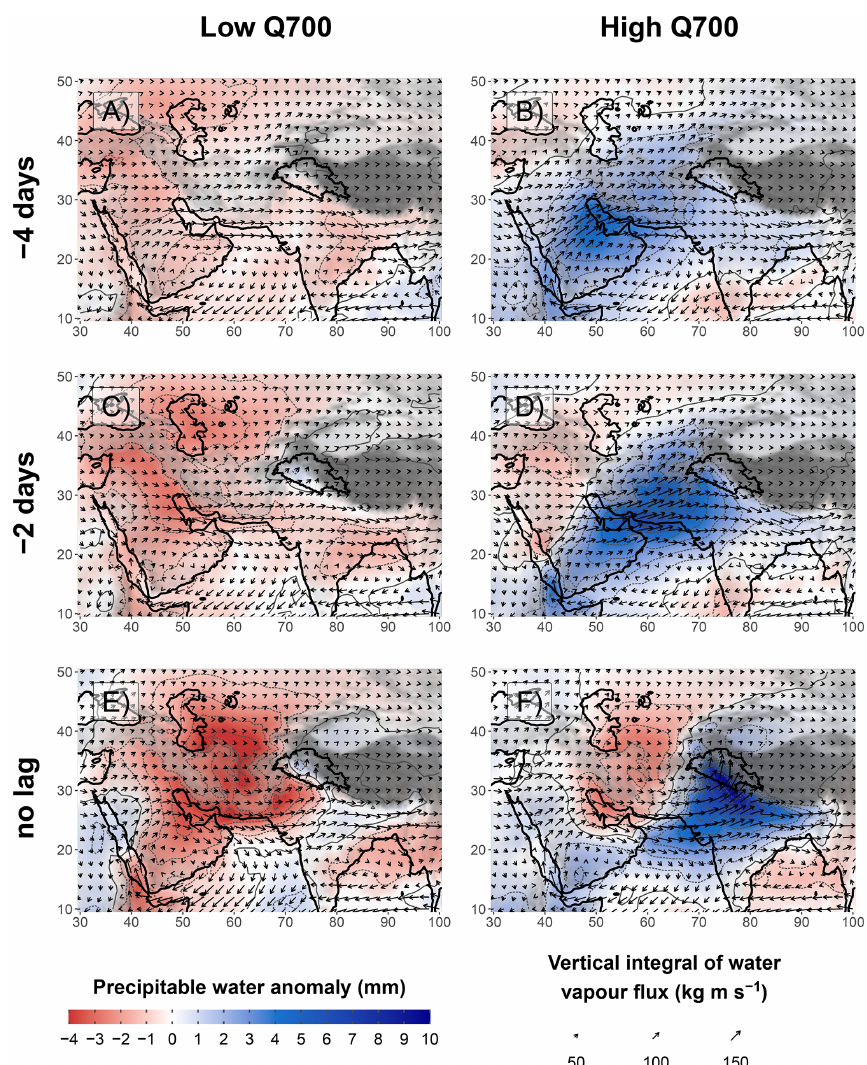
Figure 12. Same as Fig. 10b, c, and e, but the composites are based on the lowest (highest) values of Q700 in panels (a) , (c) , and (e) ( b , d , and f ). See the selection definition in Sect.